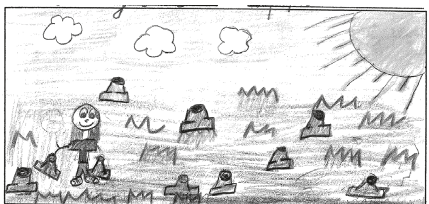
Figure 5: Photo journal drawing representing stage 3: developing leadership.